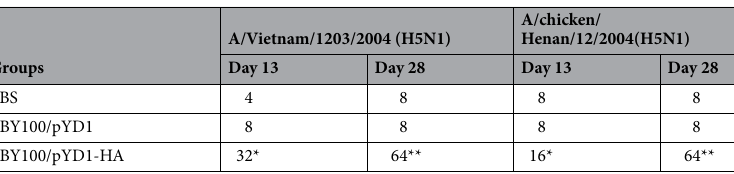
Table 1. HI titers. HI titers are representative of three independent experiments. Asterisks represent statistical significance compared with the PBS- and EBY100/pYD1 groups . * p ˂ 0.05, ** p ˂ 0.01.